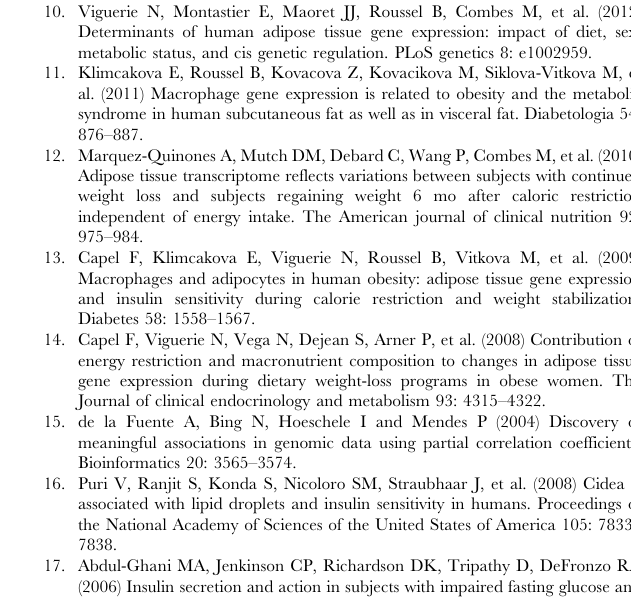
Table S1 Description of the 267 target genes. Protocol S1 Detailed study protocol of the DiOGenes